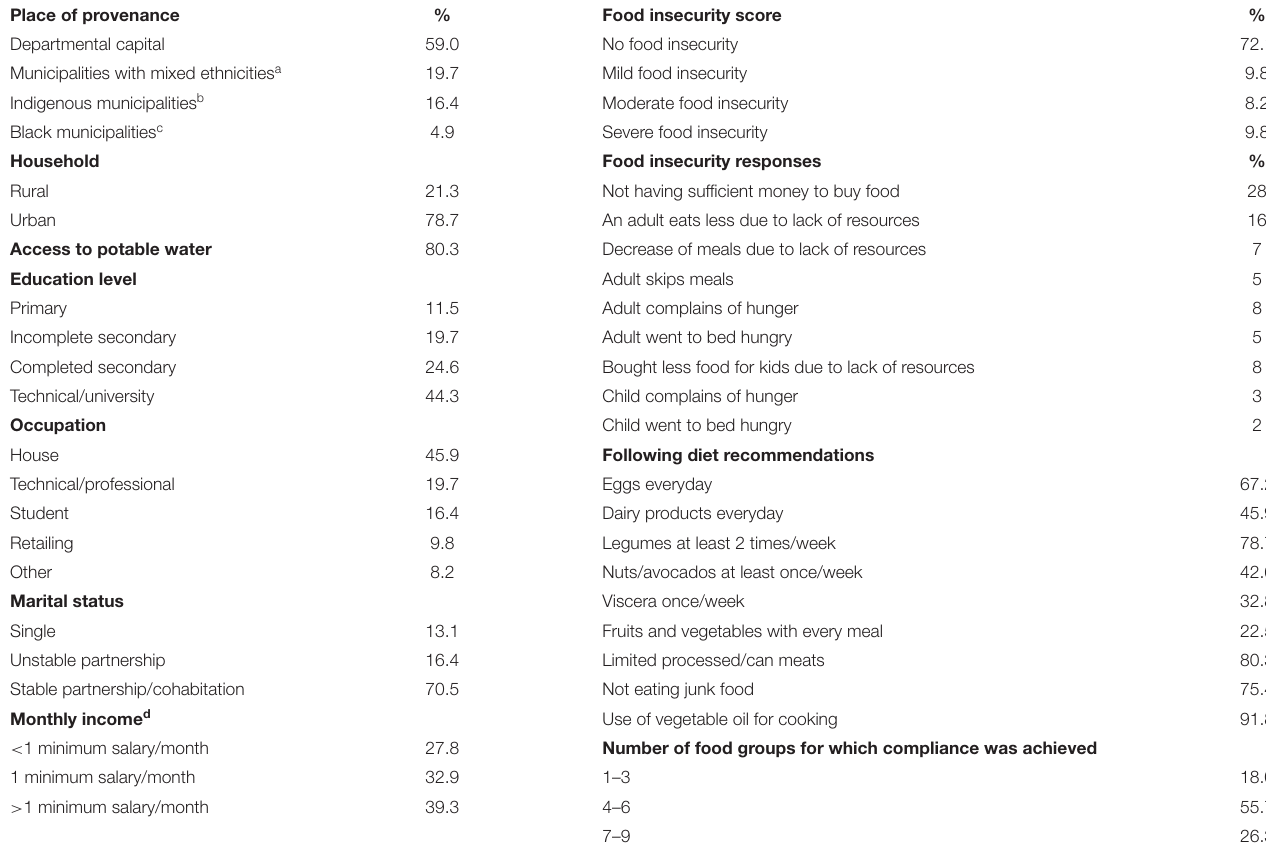
TABLE 1 | Socio-demographic and diet